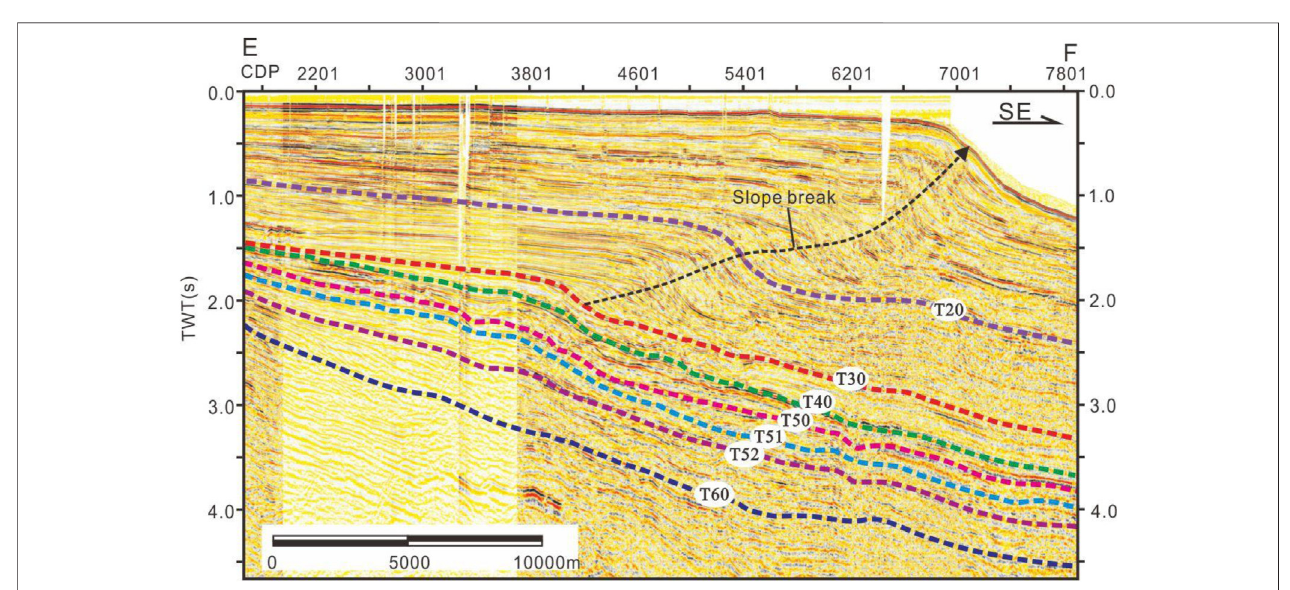
FIGURE 10 | Seismic cross-section showing the position of the prominent slope break that formed during deposition of the Yinggehai and Ledong Formations, in response to a dramatic deeping of seawater around 5.5 Ma. The location of the cross section is shown in Figure 1 .